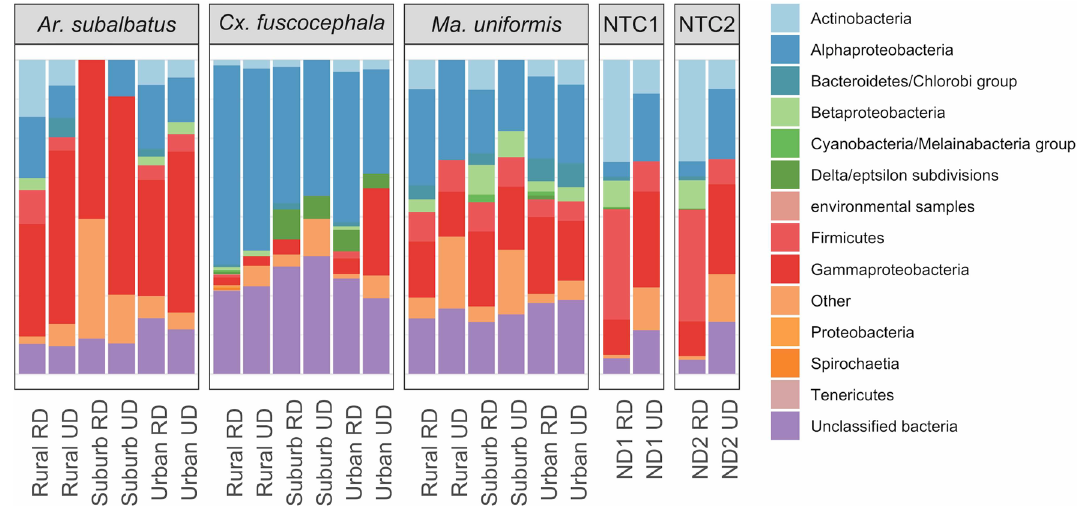
Figure 6. The proportion of bacteria groups found in all mosquito samples and NTCs. RD = rRNA depleted, UD = rRNA not depleted. NTC1 and NTC2 refer to no-template controls for separate sequencing runs (Supplementary Table